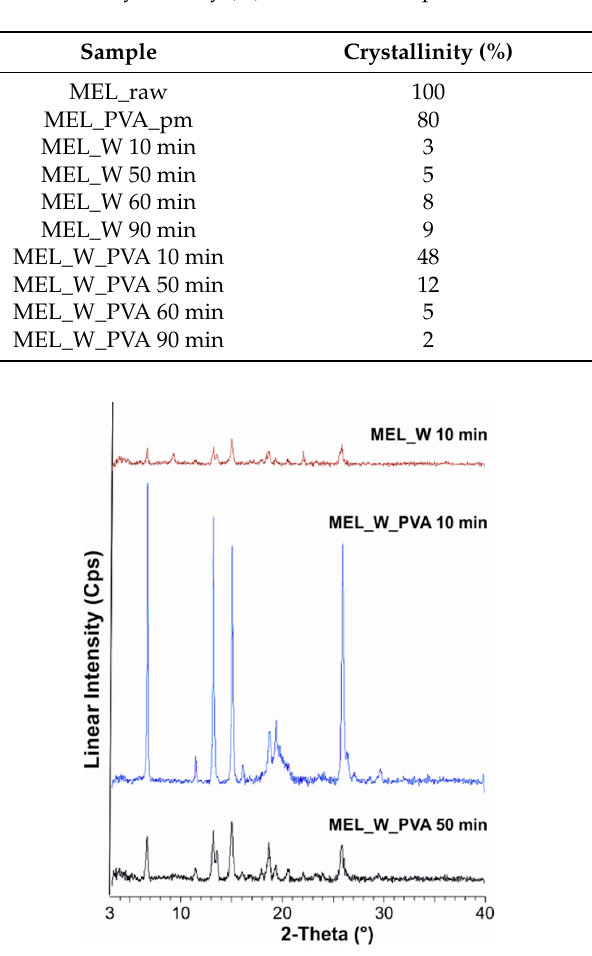
Figure 1. XRPD examination of MEL_raw and MEL_PVA_pm. Table 3. The degree of MEL crystallinity (%) for different dispersant media and milling times.